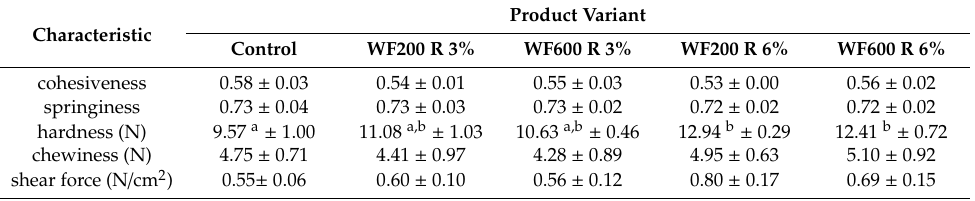
Table 3. Texture parameters of the model homogenized sterilized canned meat products (mean ± standard deviation).